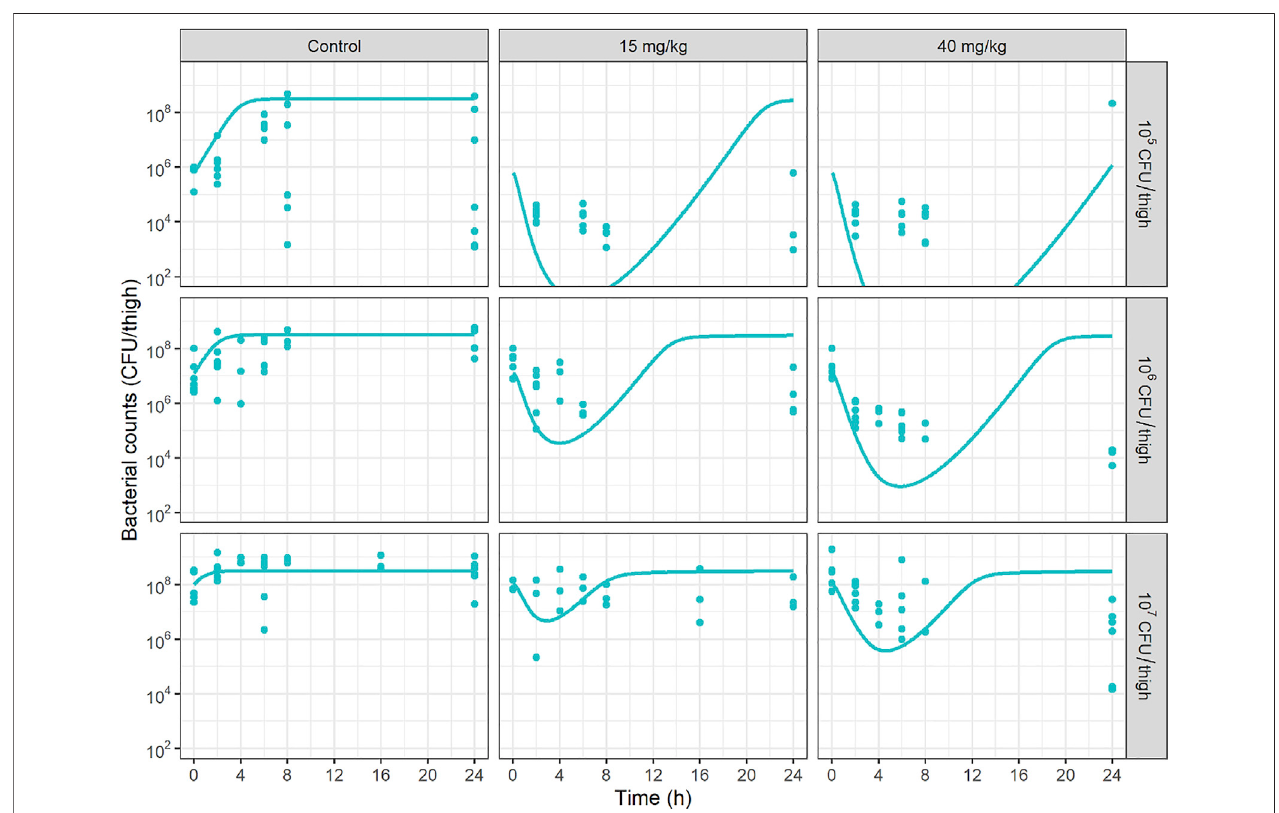
FIGURE4| Bacterialcounts(CFU/thigh)versustimepro fi lesatvariousinitialinoculapredictedbycombiningthePMBmicePKmodel,withthePDmodelpreviously developed to characterize the inoculum effect in vitro (Akrong et al., 2021). Solid circles represent experimental data and solid lines represent model predictions.